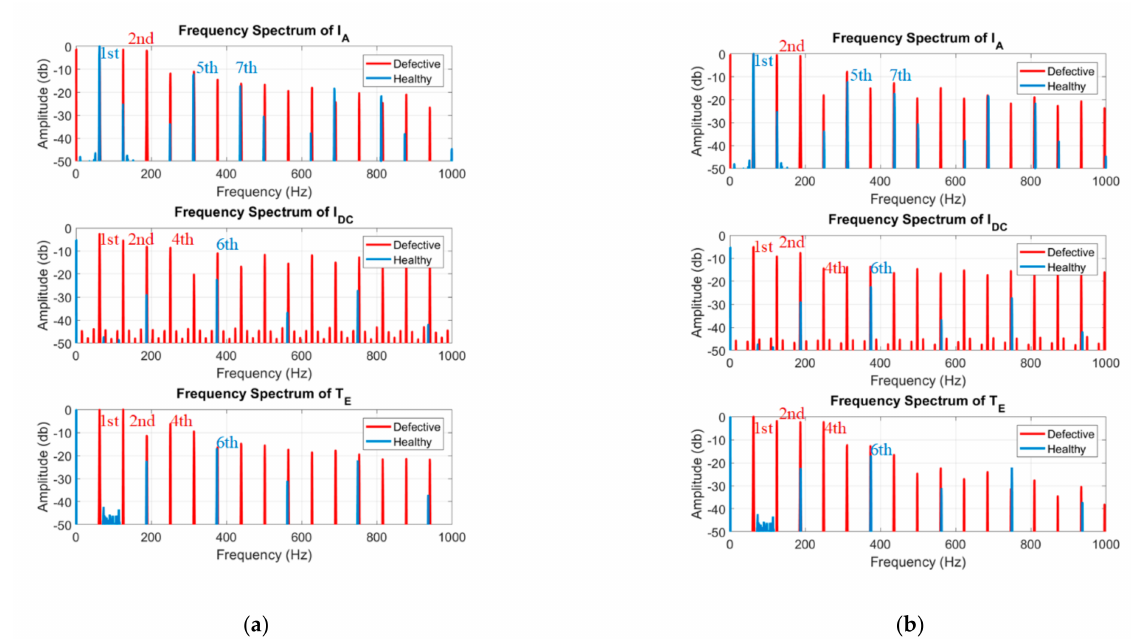
Figure 15. Comparison of phase current, DC-link current, and electromagnetic torque frequency spectra in case of 900 rpm and 10% of rated load operating point for the healthy and defective configuration of Hall-effect position sensors A and C breakdown fault. ( a ) Defective sensors A and C at high state; ( b ) Defective sensors A and C at low state.